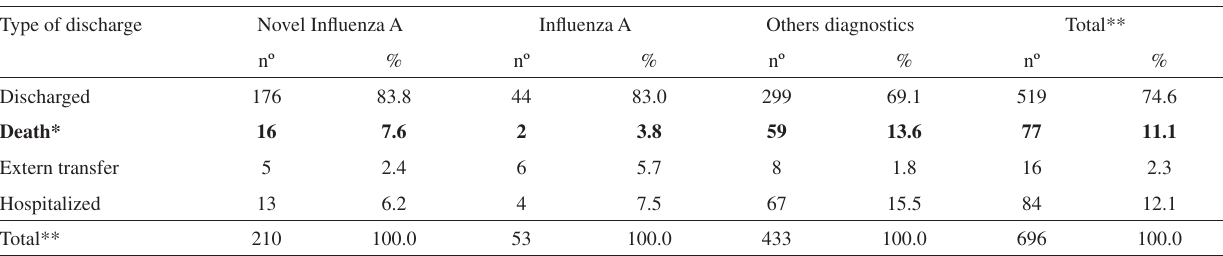
Table 3 - Hospitalized cases of acute respiratory syndrome and the clinical endpoint after final diagnostic - Hospital das Clinicas - FMUSP - June, 16 to September, 18 - 2009 Type of discharge Novel Influenza A